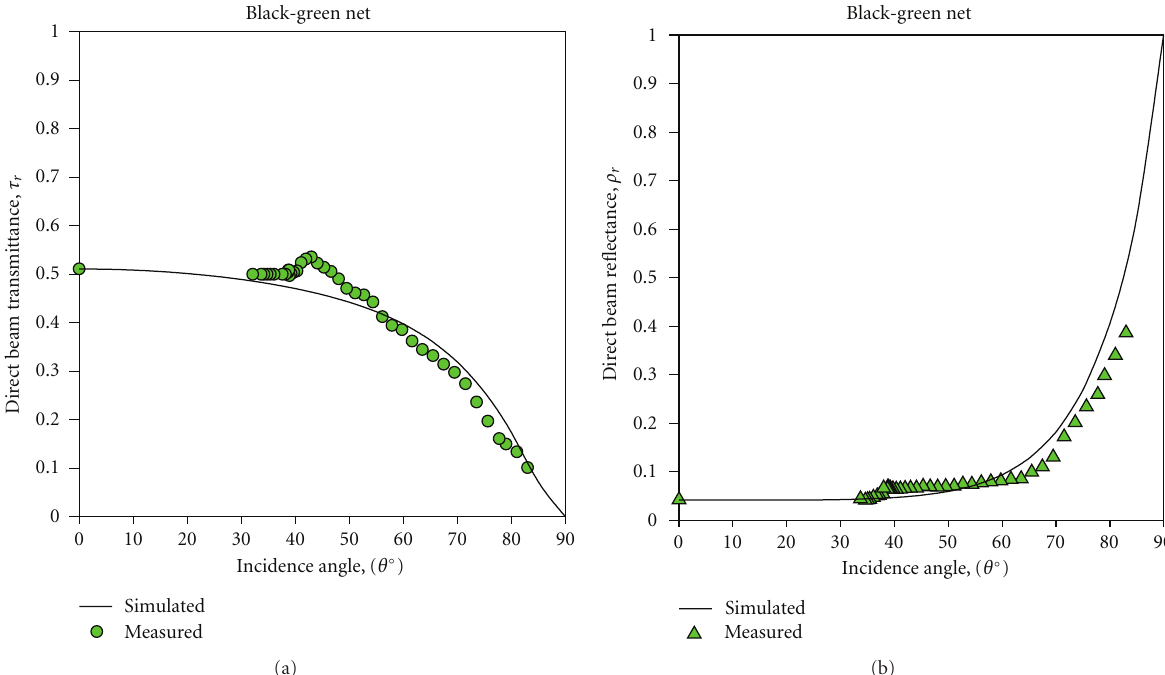
Figure 7: Comparison between the measured [8] and simulated values of (a) the direct beam transmittance ( τ r ) and (b) direct beam reflectance ( ρ r ) for the black-green